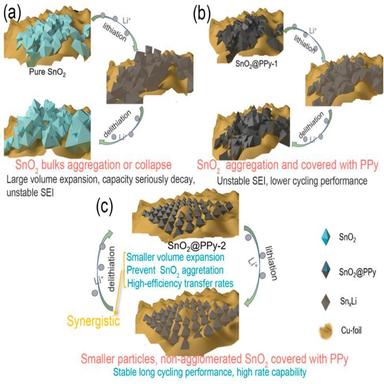
Electrochemical reaction mechanism of pure SnO2 (a), SnO2 @PPy-1(b), SnO2 @PPy-2 (c).